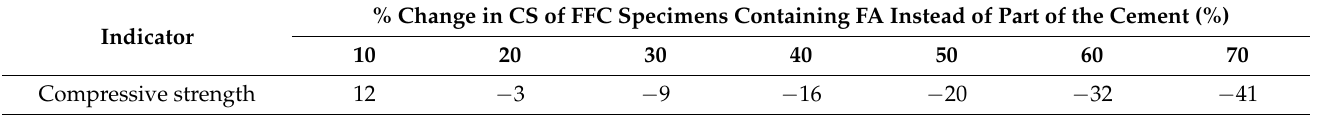
Table 9. Change in CS of FFC samples depending on the percentage of FA.